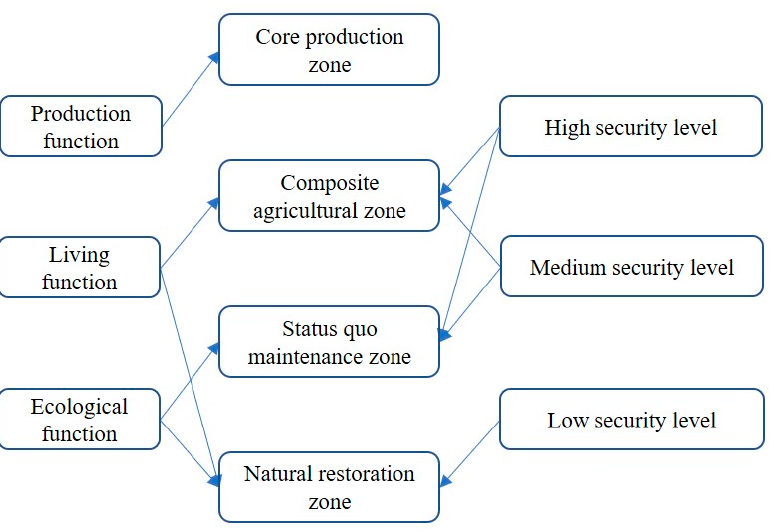
Figure 6. Adjustment of cultivated land use in Yuanyang County.